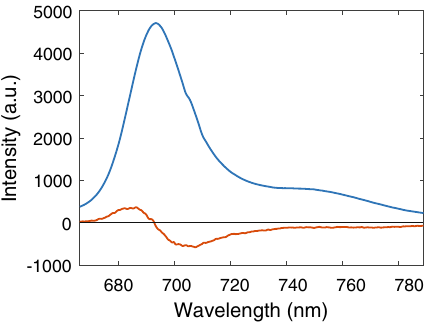
Figure 4. Decay-associated spectra of the two fluorescence decay components resolved for monomeric BChl c : 200 ps (red line) and 5050 ps (blue line).